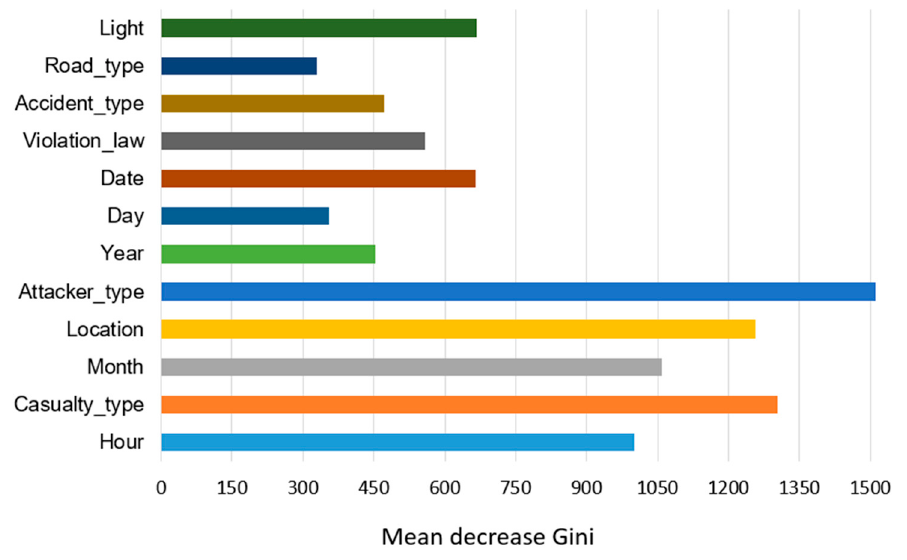
Figure 5. Variable importance using the MDG coefficient. Table 2. The final result of the variable importance using the MDG